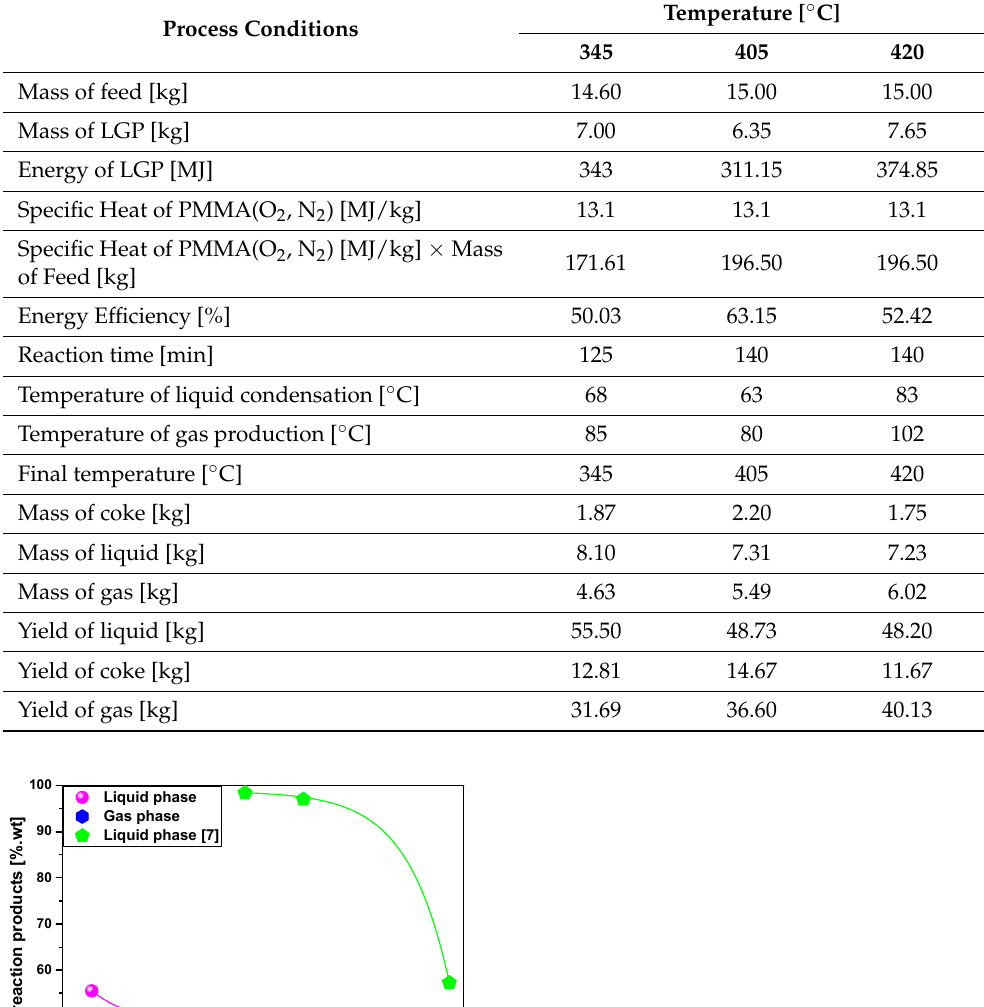
Table 2. Process conditions, mass balances, energy balance, and yields of reaction products by thermal degradation of PMMA based dental resins fragments/residues at 345, 405, and 420 ◦ C, atmospheric pressure, in pilot scale.